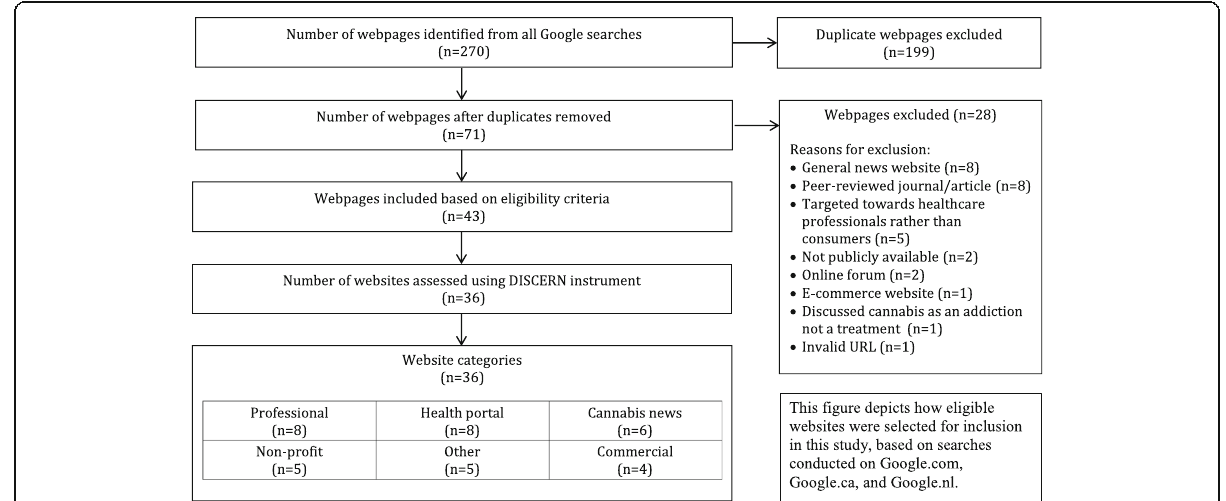
Fig. 1 Web information search strategy and assessment